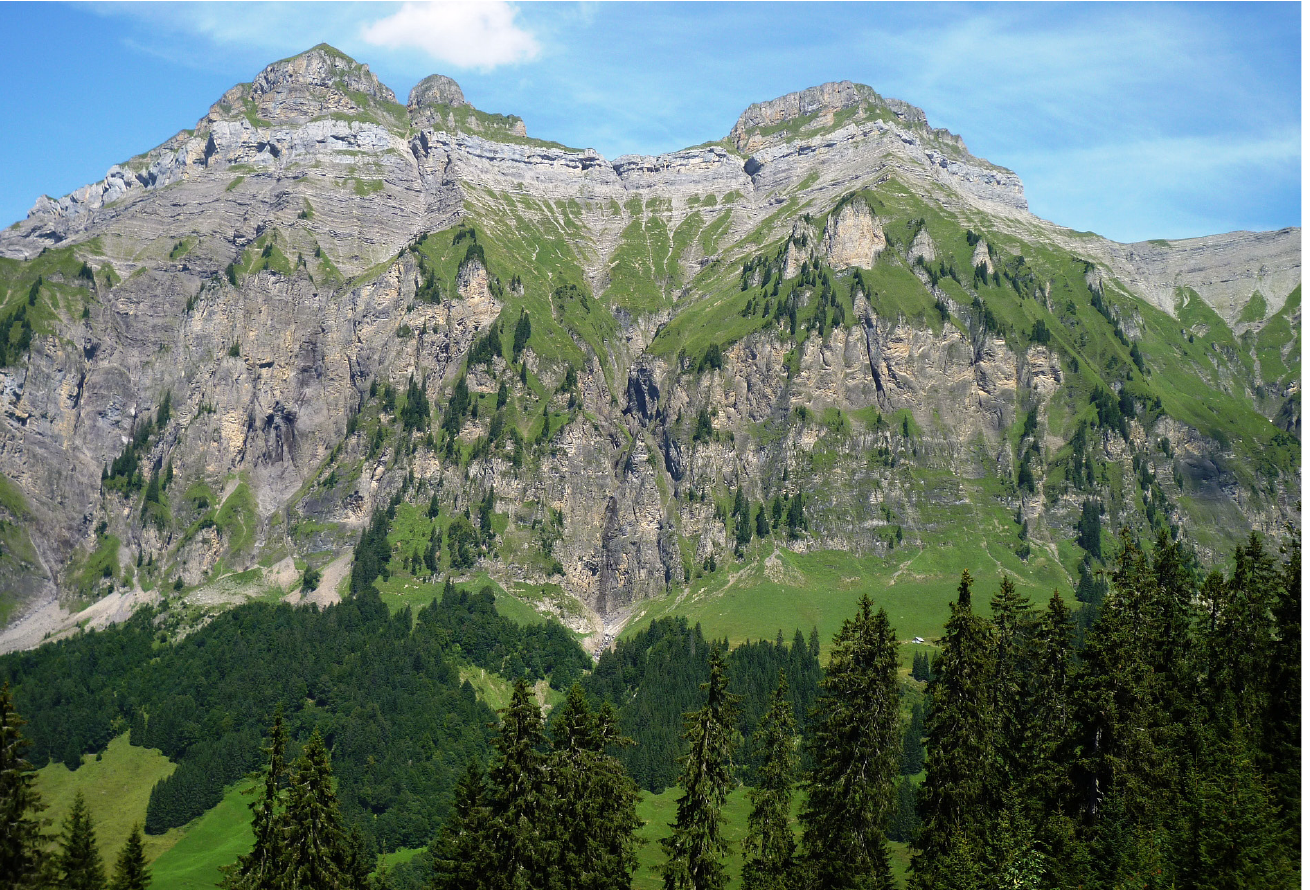
Figure 1. The photo shows the southern face of Druesberg in the northern Swiss Alps (2282 m, Muotathal). On inaccessible areas of the valley slopes, trees approximate the upper tree line. The forest boundaries are shaped by agriculture. A few decades ago, hay harvesting even on the steepest slopes (Wildheu) was essential for the subsistence of the local people. Now subsidies help to sustain the cultural